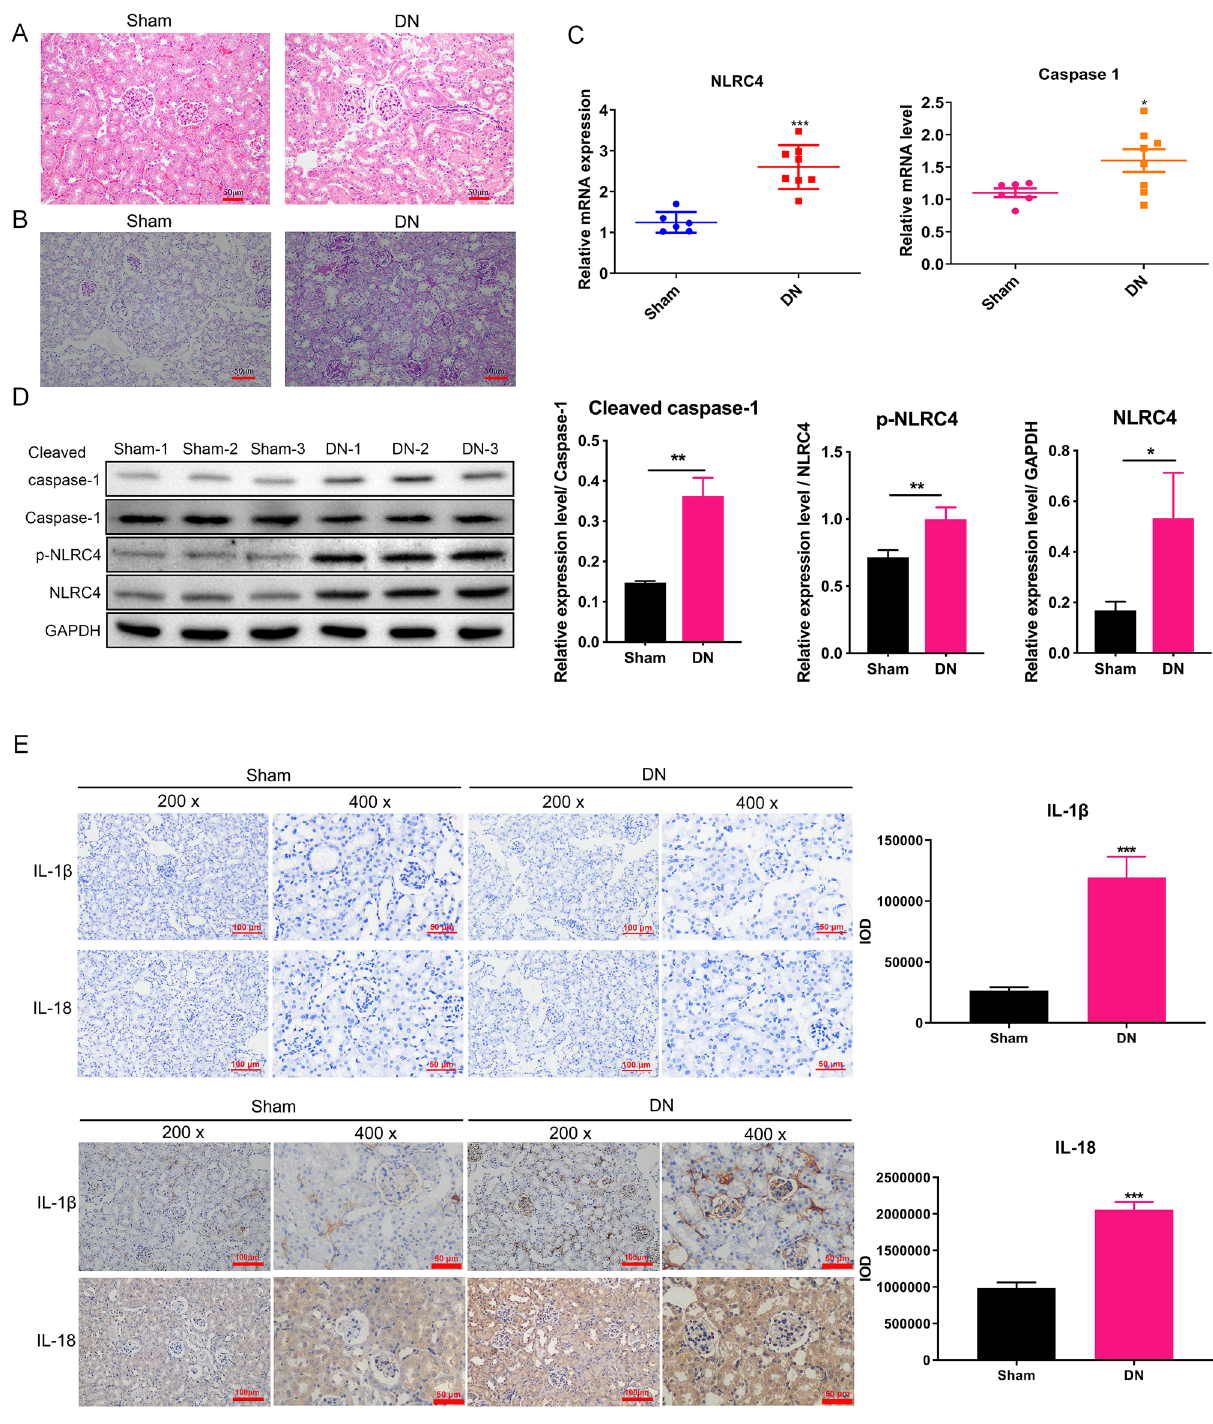
Figure 1. The pathological characteristics and NLRC4 expression in DN mice. ( A ) The H&E staining of the kidney tissues was used to show the changes in structure of the sham (n = 3) and DN mice (n = 3). ( B ) The PAS staining of the kidney tissues was used to show the content of sugars in sham (n = 3) and DN mice (n = 3). ( C ) The mRNA levels of NLRC4 and Caspase1 were measured using qPCR in the kidney tissues of sham (n = 6) and DN mice (n = 8). ( D ) The WB analysis was used to detect NLRC4 and Caspase1 protein levels in the kidney tissues of sham (n = 3) and DN mice (n = 3). The origianl images were cut prior to hybridisation with antibodies during blotting. ( E ) The IHC analysis was used to determine the expression of IL-1β and IL-18 in the kidney tissues of sham (n = 3) and DN mice (n = 3). Upper left panel is negative controls for IHC with no primary antibodies incubation, lower left panel is the results using IL-1β and IL-18 antibody incubation. Right is the quantification of the lower left panel, and IOD equal to mean density ( average reaction intensity of positive cells) multiply by area of positive cells. * P < 0.05; ** P < 0.01; *** P < 0.001. Data are presented as the means ± SD from three independent